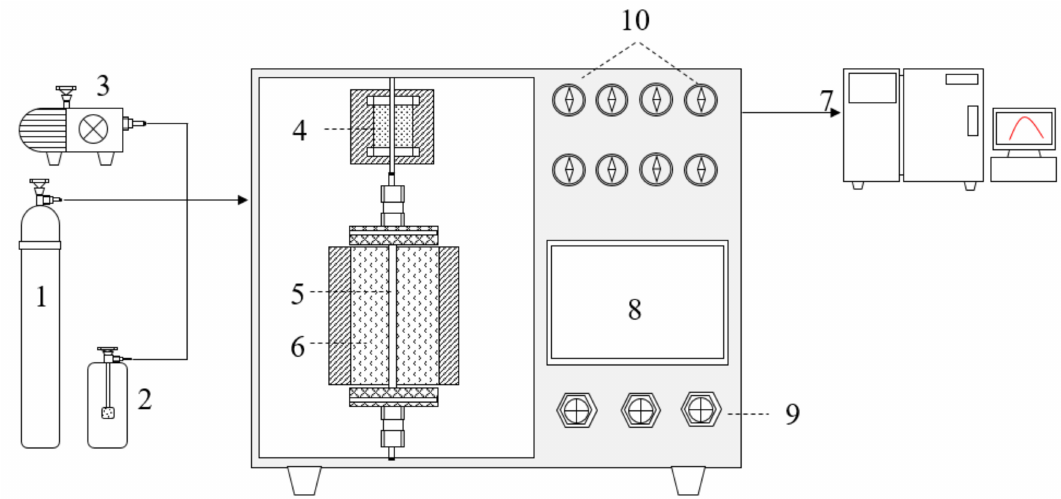
Figure 1. Chlorobenzene (CB) oxidation reaction device. 1 gas cylinder; 2 CB generator; 3 air pumps; 4 preheating furnaces; 5 silica tube; 6 holding furnace; 7 gas chromatograph (GC); 8 controlling